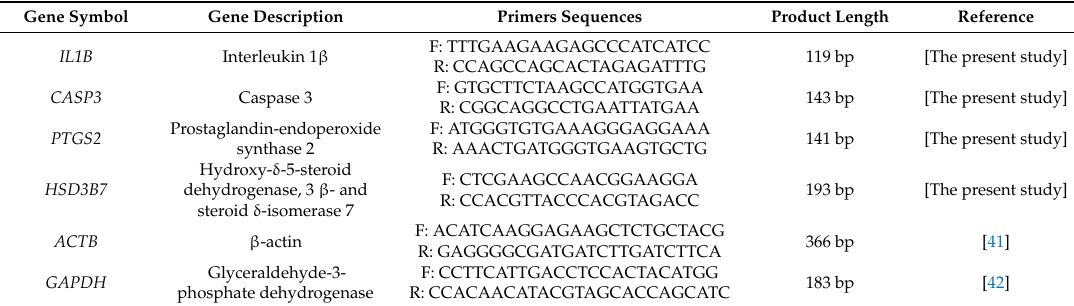
Table 1. Primers used for the validation of RNA-Seq